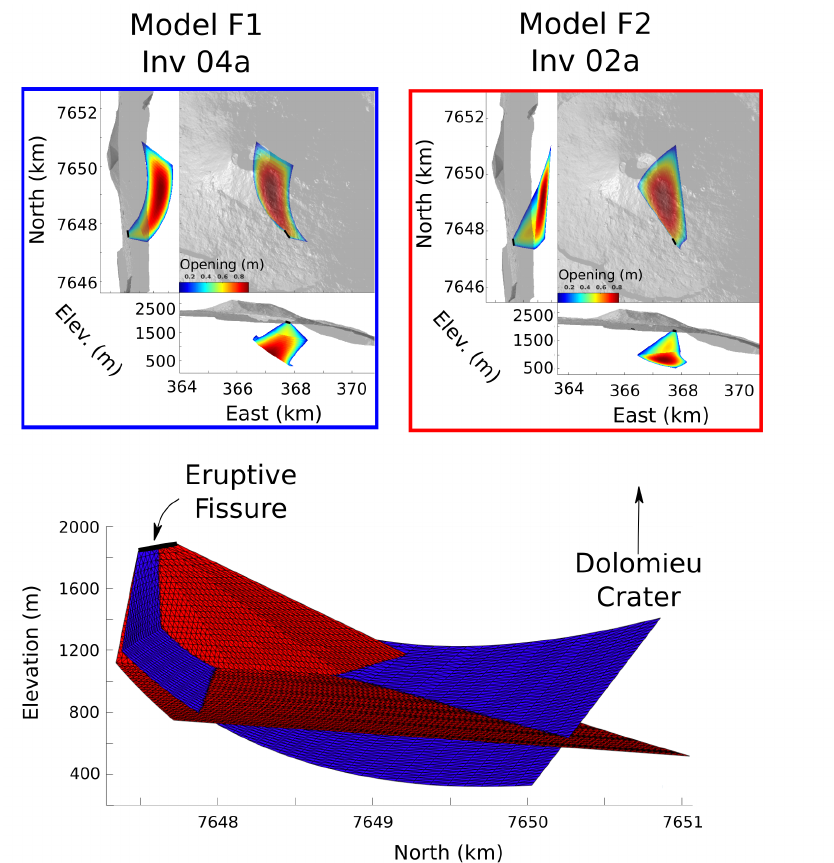
Figure 6. Comparison between geometries of typical intrusions of family F1 (Inv04a in blue) and family F2 (Inv02a in red). The upper plots compare the geometry and fracture opening of intrusions of family F1 ( left ) and family F2 ( right ). Three views are shown for each subfigure, one from the east along the northern direction on the left-hand side, a map view on the right-hand side and a view from the south along the eastern direction at the bottom. The lower plot compares the eruptive fracture meshes for the two families, as seen from the